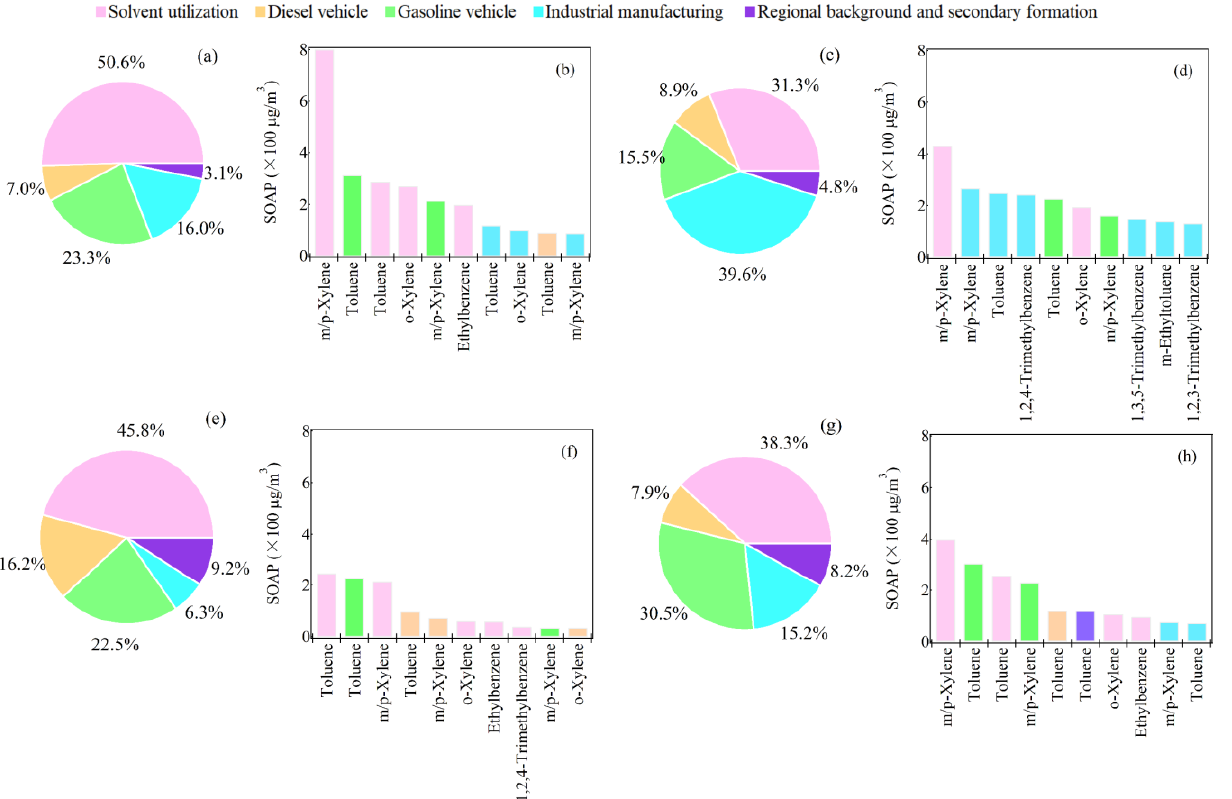
Figure 17. Contribution of different sources extracted from PMF to the total SOAPs in ( a ) spring, ( c ) summer, ( e ) fall, ( g ) winter, and SOAP values of the top ten VOCs from different sources in ( b ) spring, ( d ) summer, ( f ) fall, and ( h ) winter.